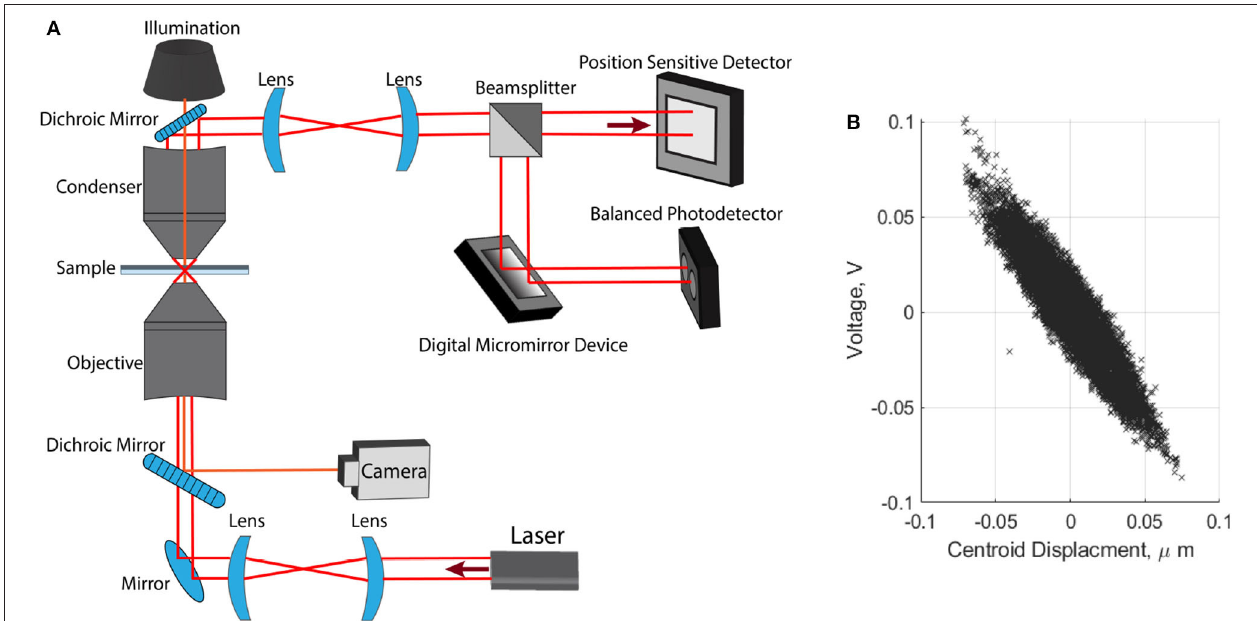
FIGURE 2 | Optical tweezer apparatus. (A) Layout of optical tweezer setup used for trapping and three dimensional direct force detection. (B) Synchronous position-voltage measurements, used to confirm linearity of our optical